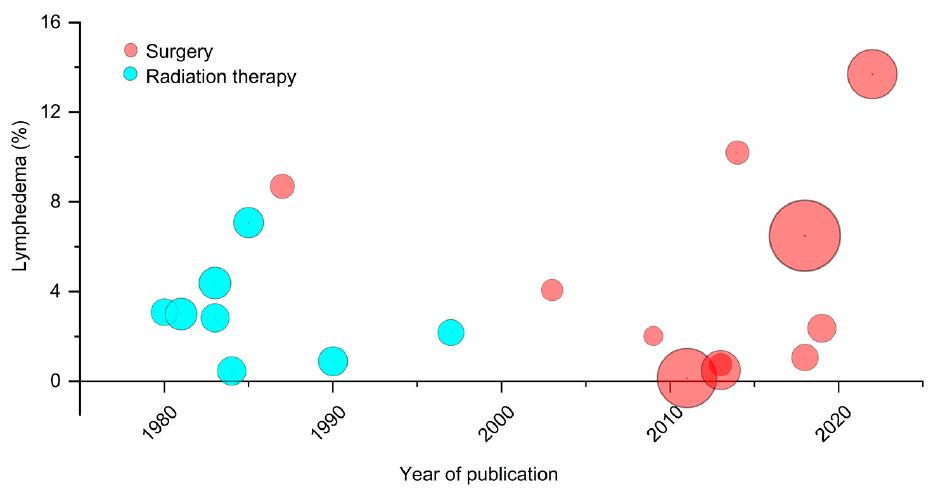
Figure 4. Bubble plots, depicting the prevalence of lower limb lymphedema for surgery (blue) and radiation therapy (orange) over time. Bubble area corresponds to the sample size.